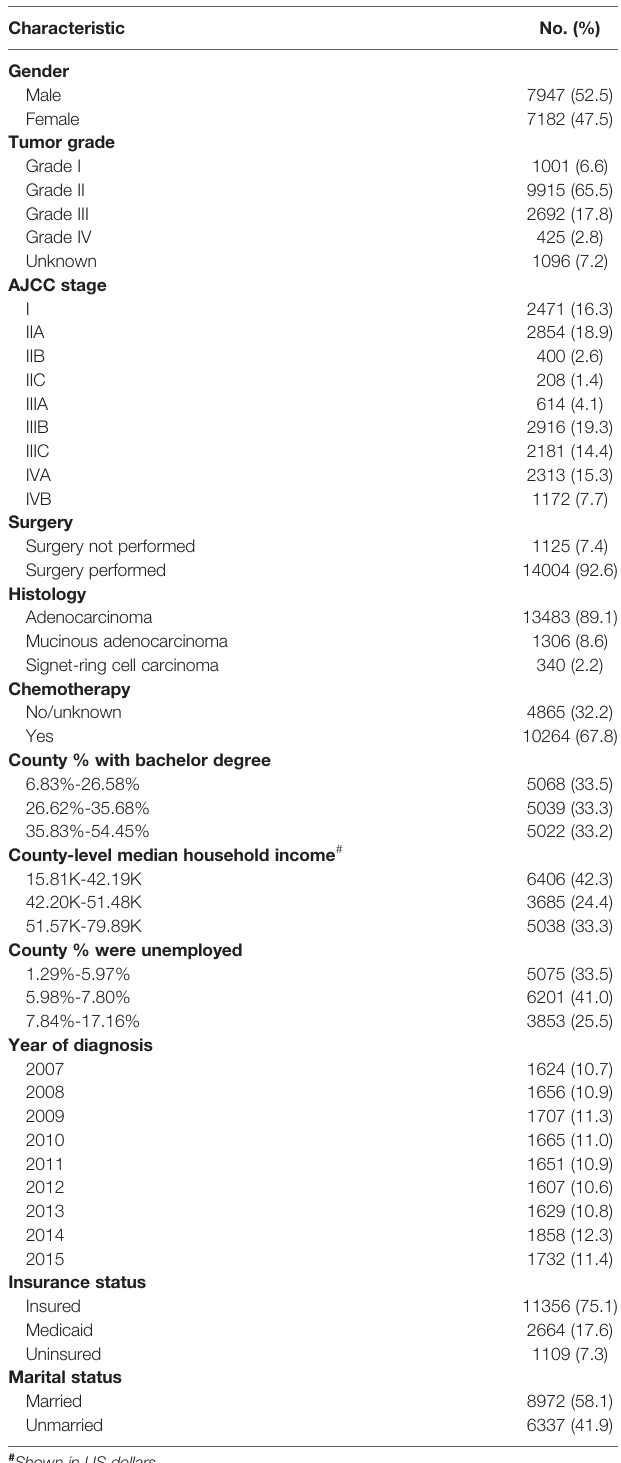
TABLE 1 | Baseline characteristics of colon cancer patients included in our